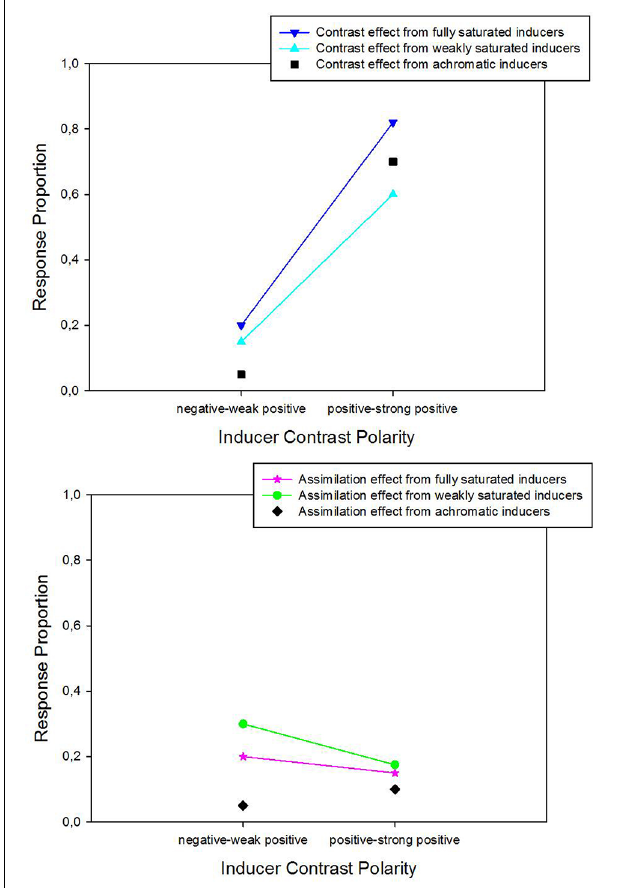
FIGURE 6 | Average response proportions for contrast (upper panel) and assimilation (lower panel) as a function of the contrast polarity